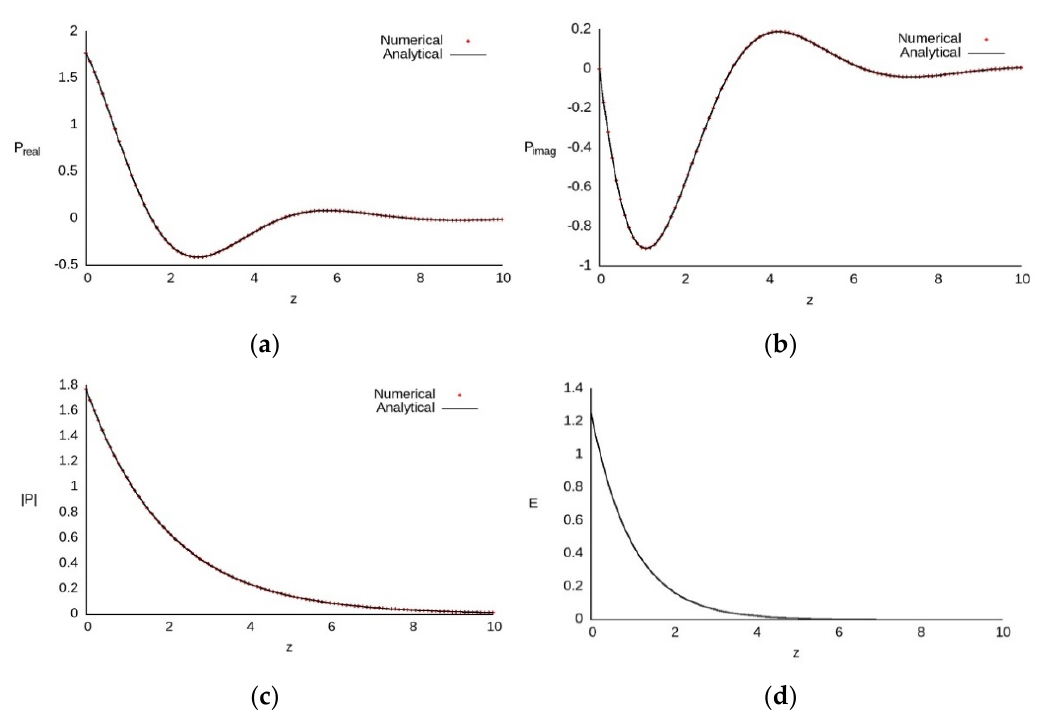
Figure 2. The function P ( z , L t ) (4c) evolution: real part ( a ), imaginary part ( b ), its modulus ( c ), and the pulse’s energy ( d ) obtained via computer simulation (red dotted line) and analytical solution (black solid line) with the parameters D 2 ω = 0, δ 0 = 1, n 0 = 2